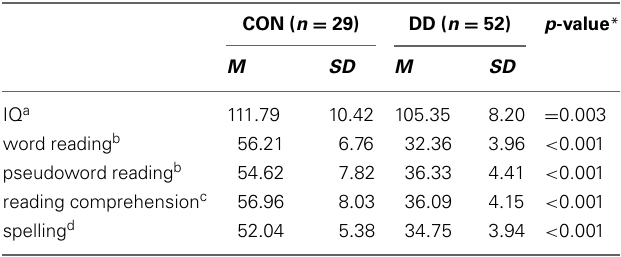
Table 1 | Descriptive statistics of control children and children